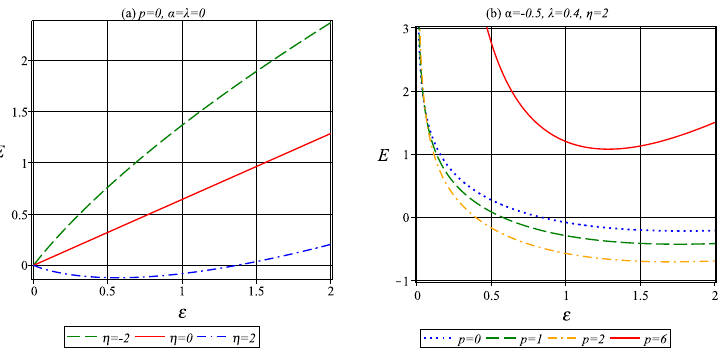
Figure 5 . Effect of perturbative corrections on the internal energy for c T = c S = 1 .